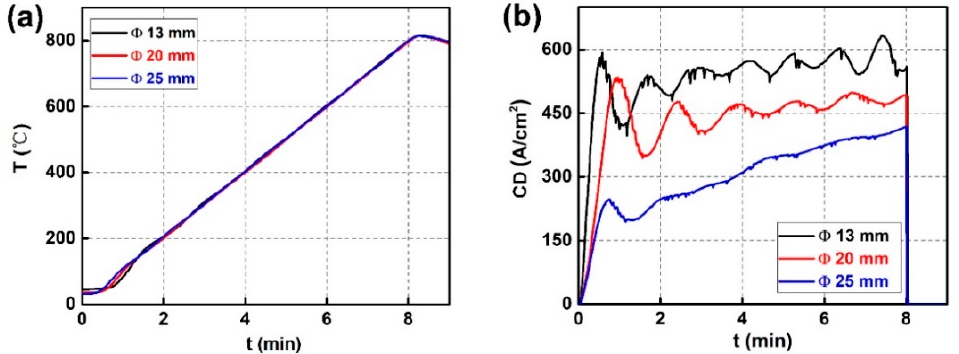
Figure 3. ( a ) FAST joining process and ( b ) the current density (CD) change curves of the W foil laminates with different diameters.